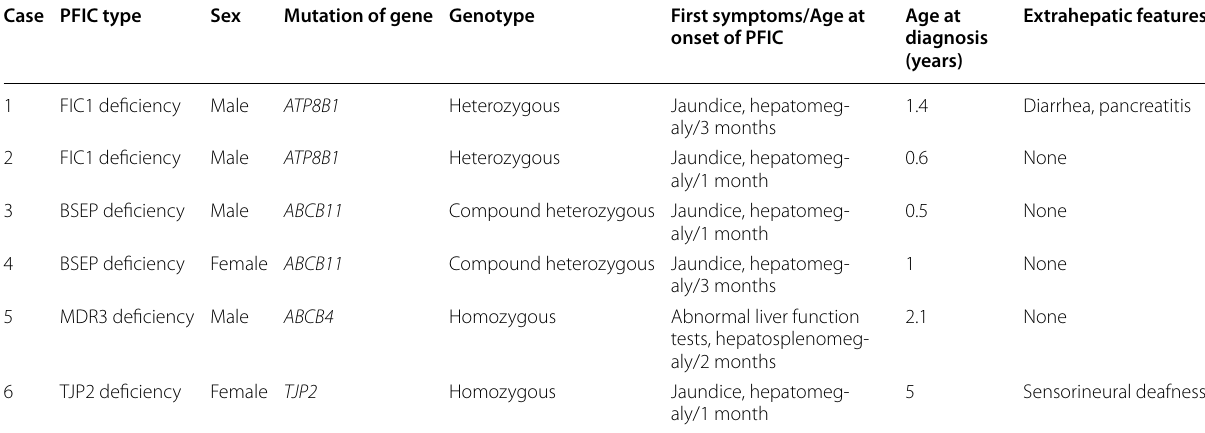
Table 1 Demographic characteristics of patients with